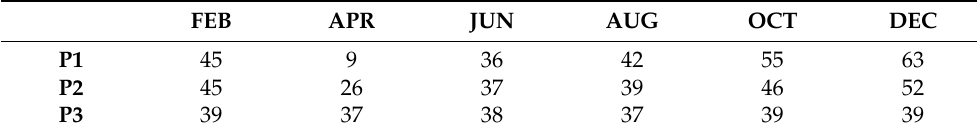
Table 2. Salinity at the three sampling points (P1, P2, and P3) in Piranji Estuary (equatorial South- western Atlantic, Brazil, 2015). Point upstream of the river (P1) to the point closest to the estuarine mouth (P3).